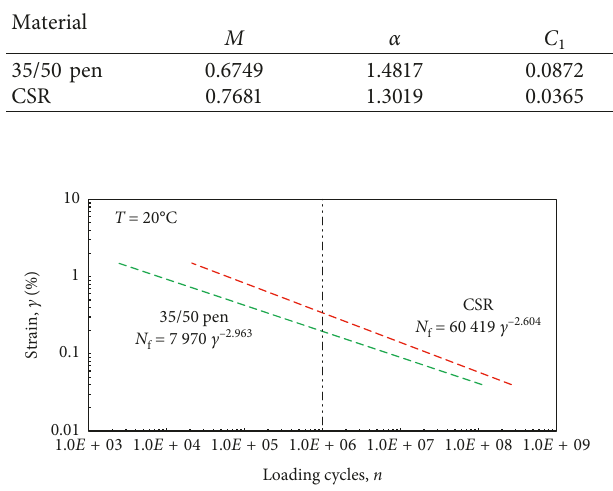
Figure 20: LAS test results ( c vs. n )—35/50 pen vs. CSR predicted fatigue lines. Figure 21: LAS test results ( N